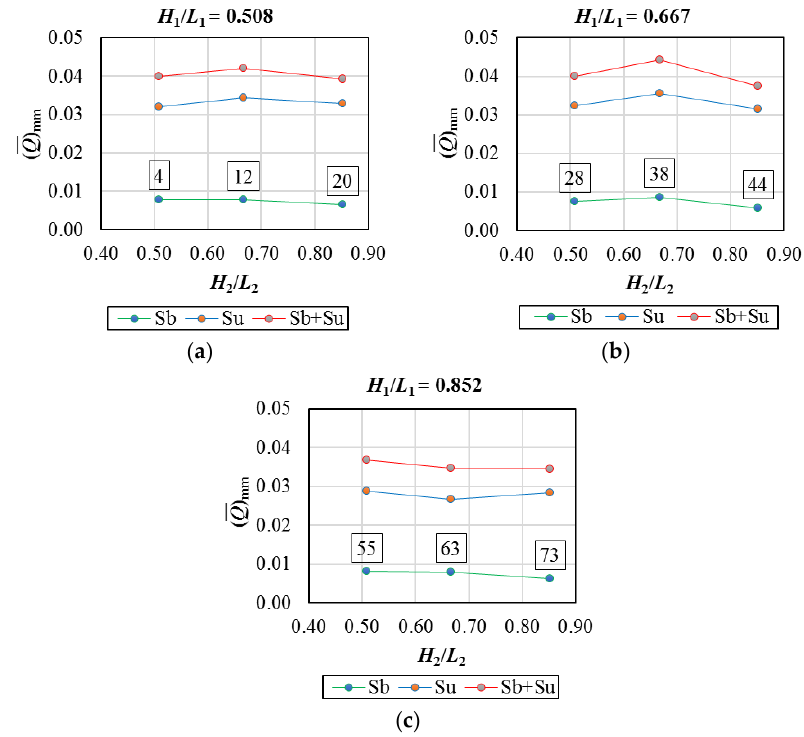
Figure 27. Behavior of ( Q ̅ ) mm x H 2 / L 2 for: ( a ) H 1 / L 1 = 0.508, ( b ) H 1 / L 1 = 0.667 and ( c ) H 1 / L 1 = 0.852.